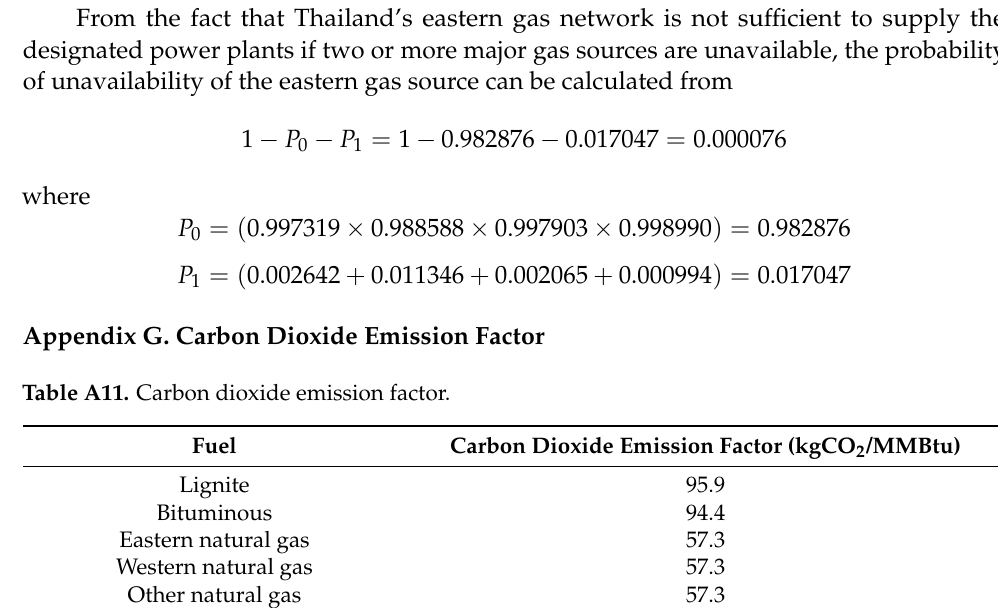
From the fact that Thailand’s eastern gas network is not sufficient to supply the designated power plants if two or more major gas sources are unavailable, the probability of unavailability of the eastern gas source can be calculated from